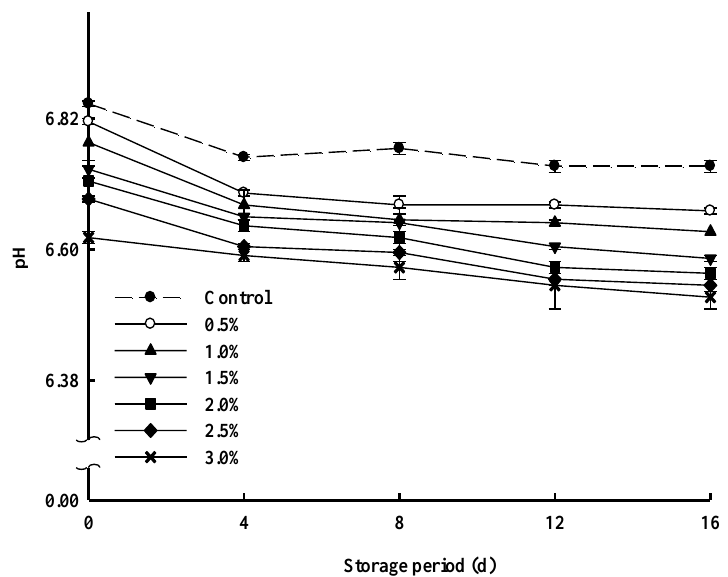
Figure 2. Changes in pH of powdered peanut sprout extract microcapsule-supplemented milk stored at 4  C for 16 d.